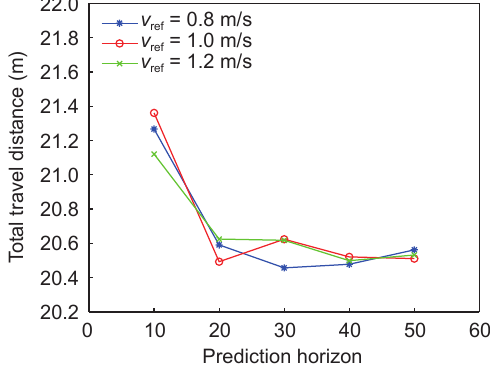
Fig. 9 Comparison of the total travel distance under different v and N . ref